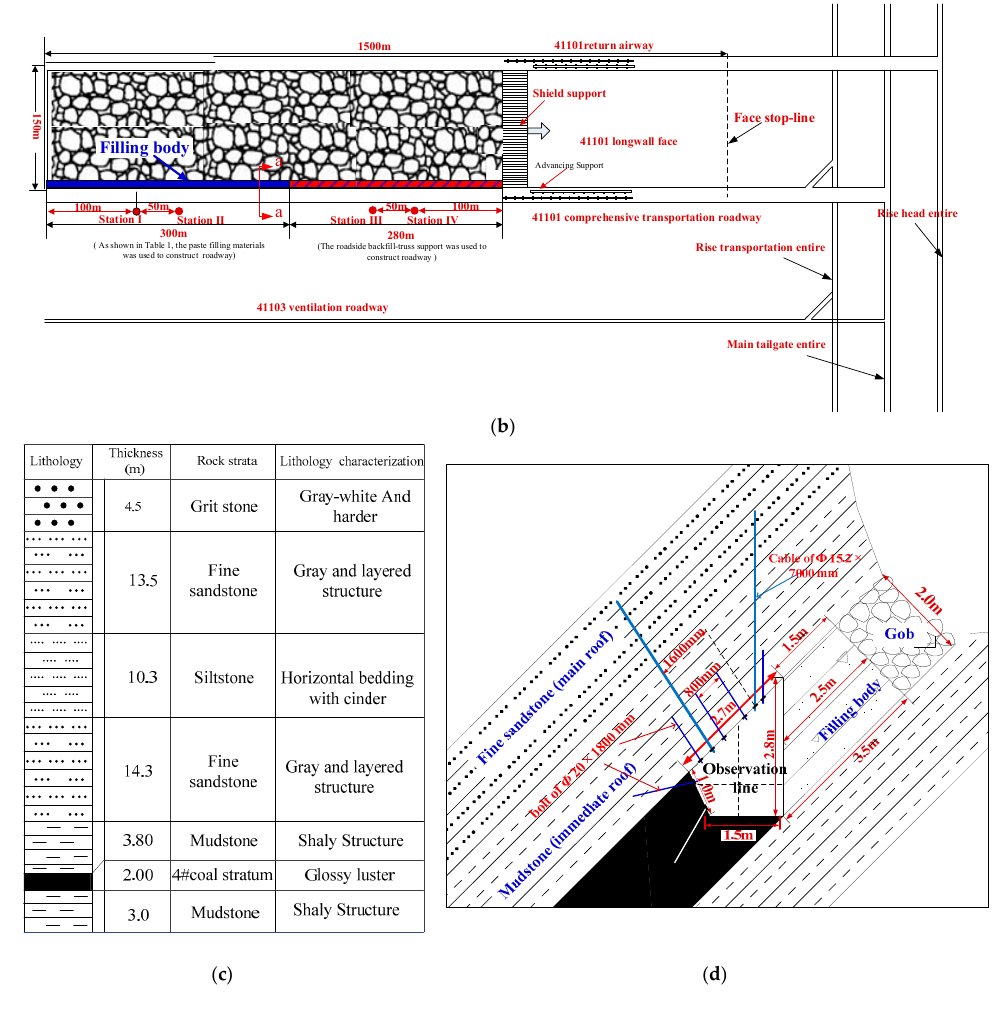
Figure 1. Layout of working face No. 41101: ( a ) layout of working face; ( b ) layout of observation stations; ( c ) lithological profile of roof strata; and ( d ) section a-a.